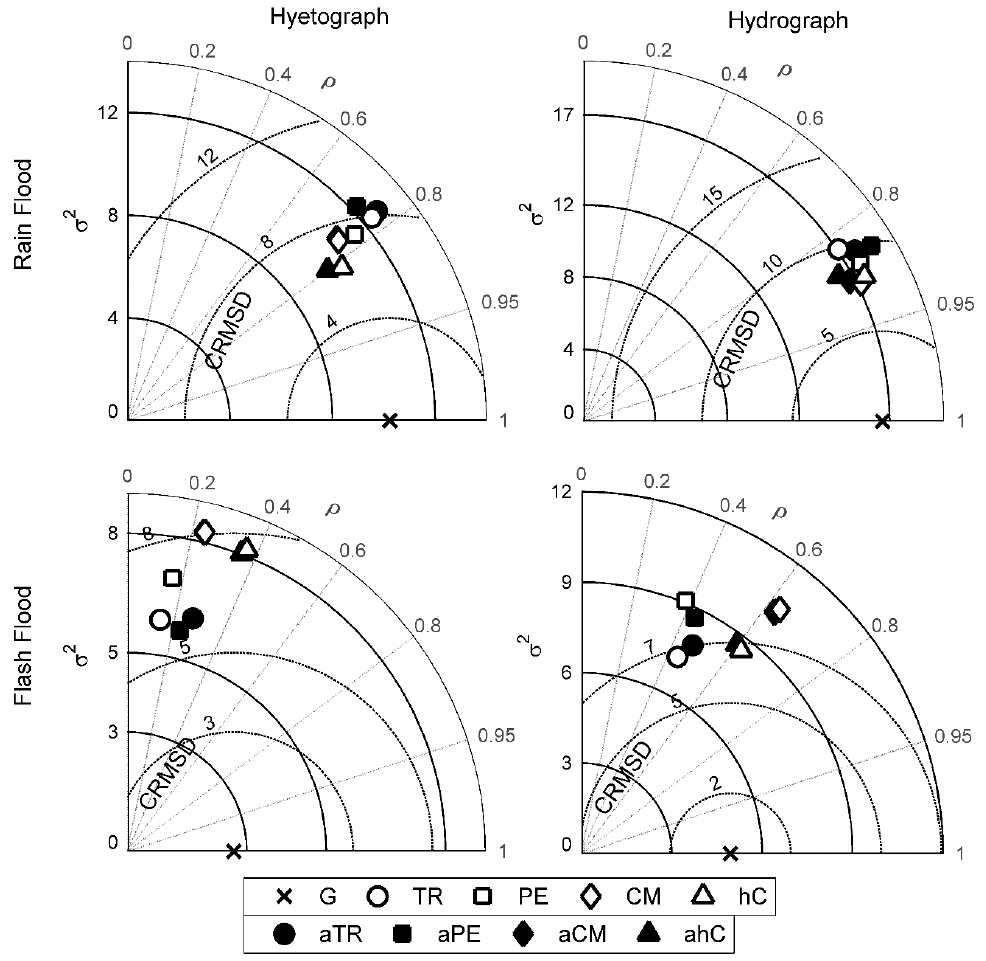
Figure 5 . Same as in Figure 3, but for the spreadness. Figure 5. Same as in Figure 3, but for the